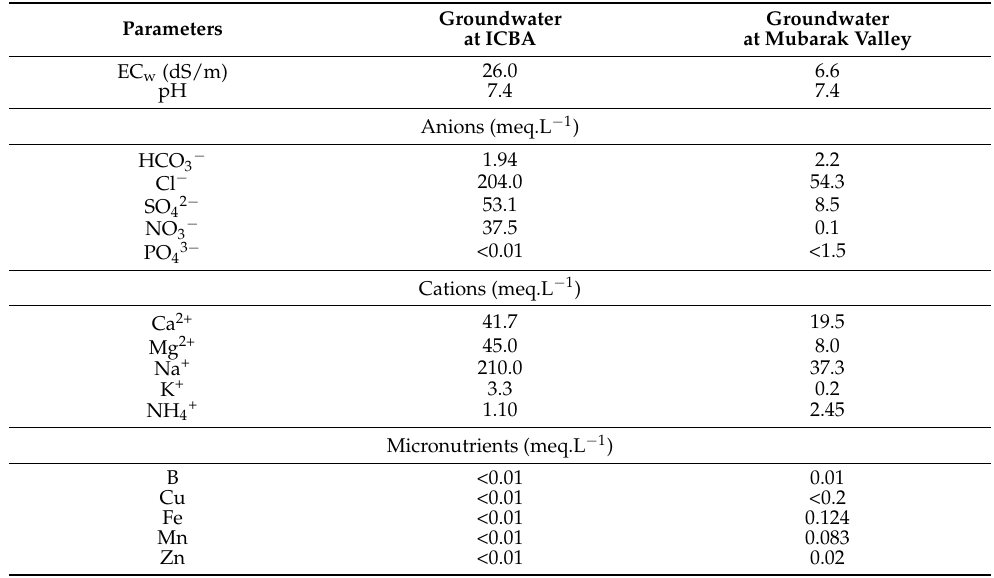
Table 4. Chemical analysis of the groundwater at ICBA’s experimental station and Mubarak